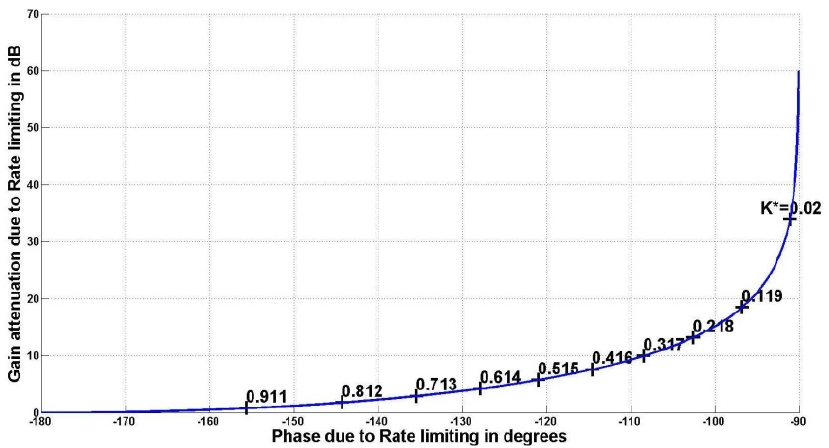
Figure 18. Rate limit describing function characteristics.